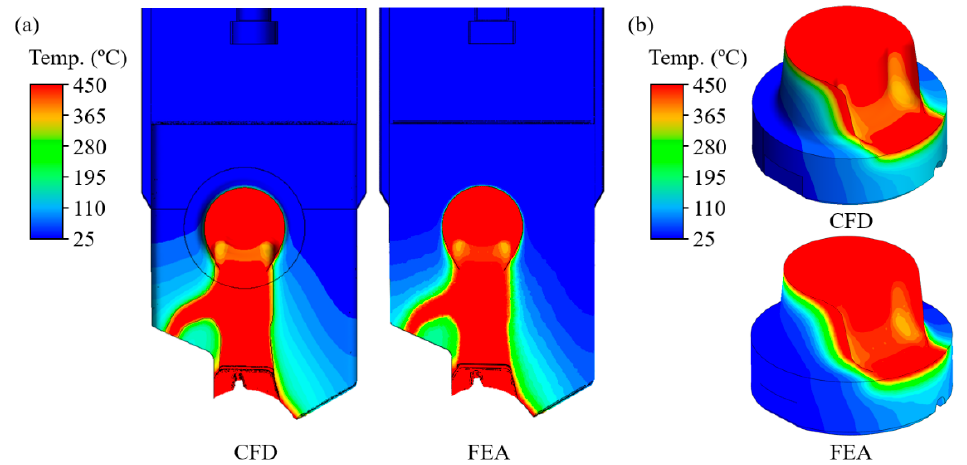
Figure 14. Temperature distribution of thermofluid analysis and IDW interpolation. ( a ) Temperature from the top view of the entire analysis model ( left : CFD, right : FEA). ( b ) Temperature from an isometric perspective of the distributor ( top : CFD, bottom : FEA).